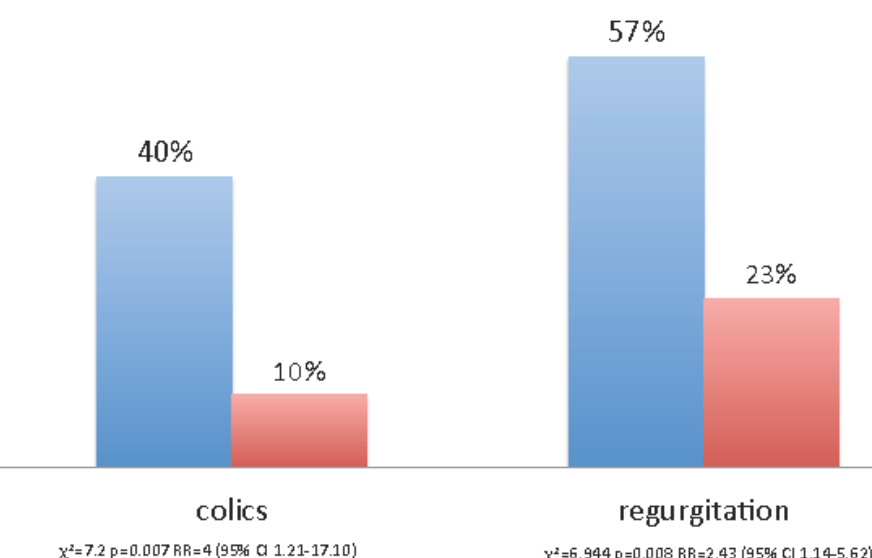
Figure 6. Functional gastrointestinal disorders (FGIDs) in treatment (T) and control (C) groups.